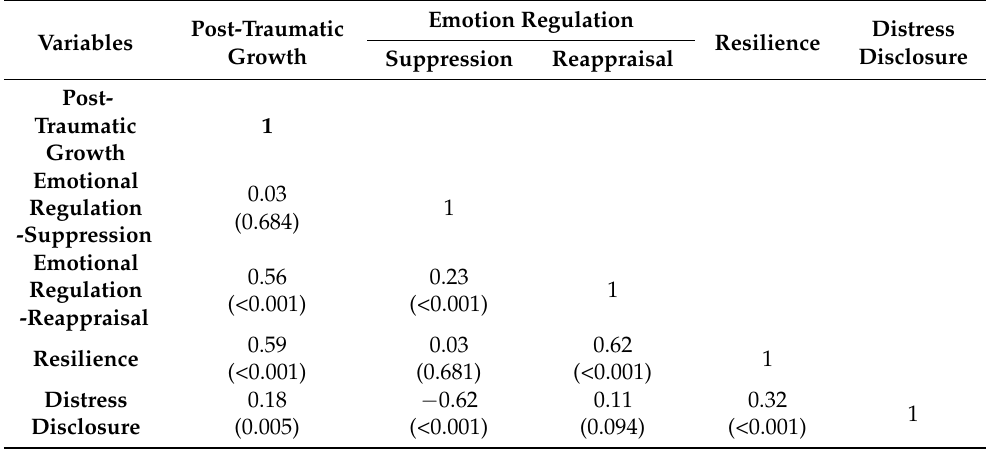
Table 3. Correlation among emotional regulation, resilience, distress disclosure, and post-traumatic